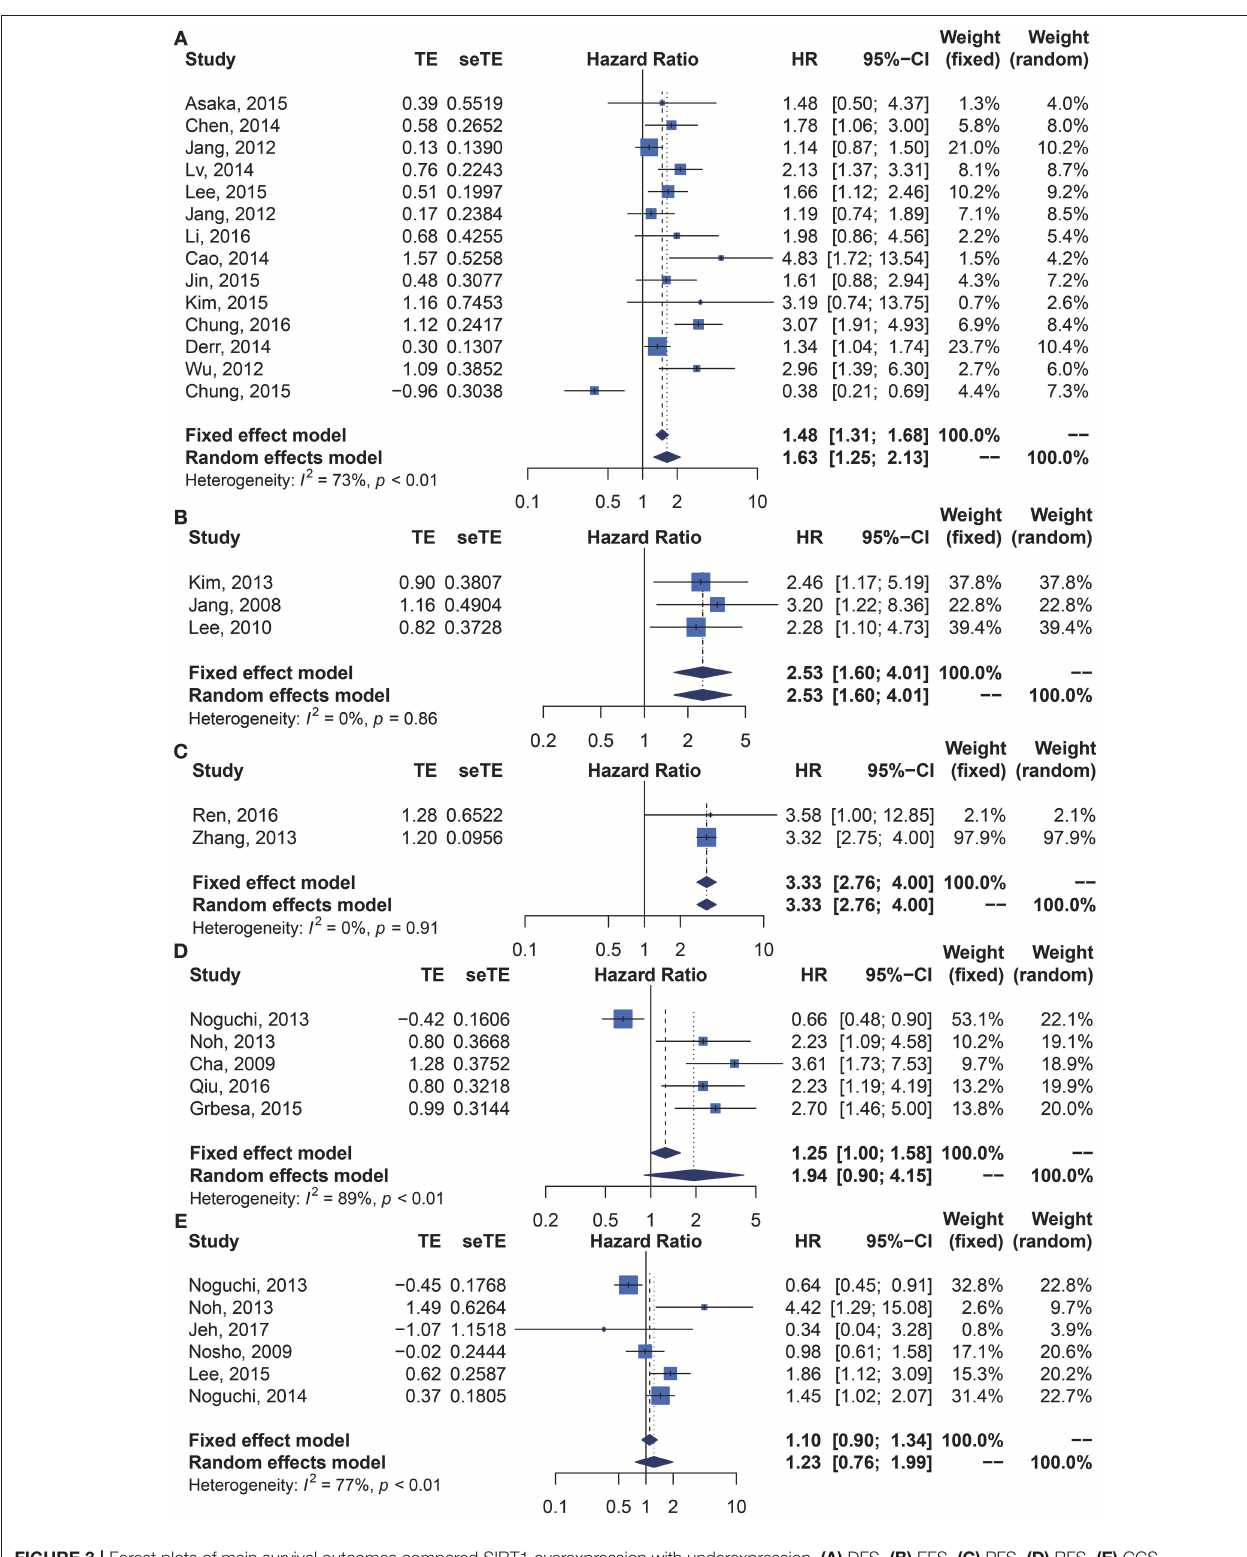
Frontiers in Endocrinology |